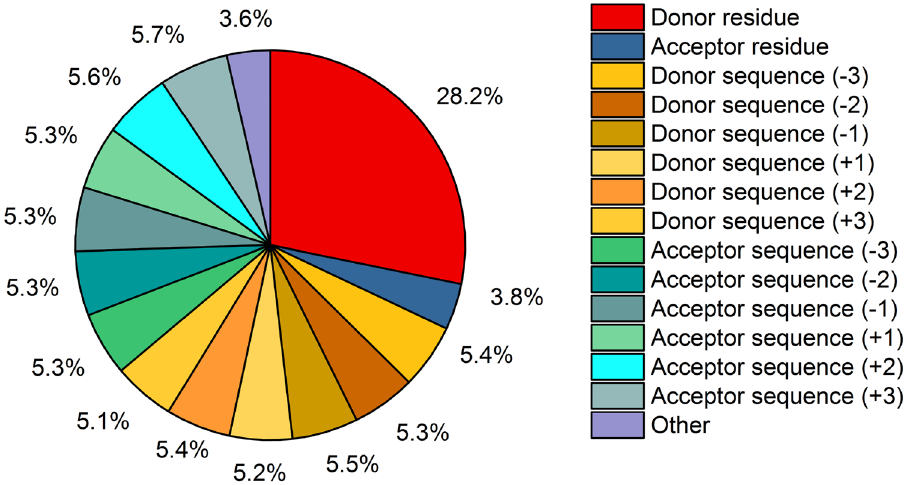
Figure 2. Normalized importance scores for the 21 input features of the MAPSHB model. The features that contribute ≤ 1% to the predictions are grouped as the “other” type. These include the atom type, charge and secondary structure of the donor and acceptor groups and the location of the acceptor